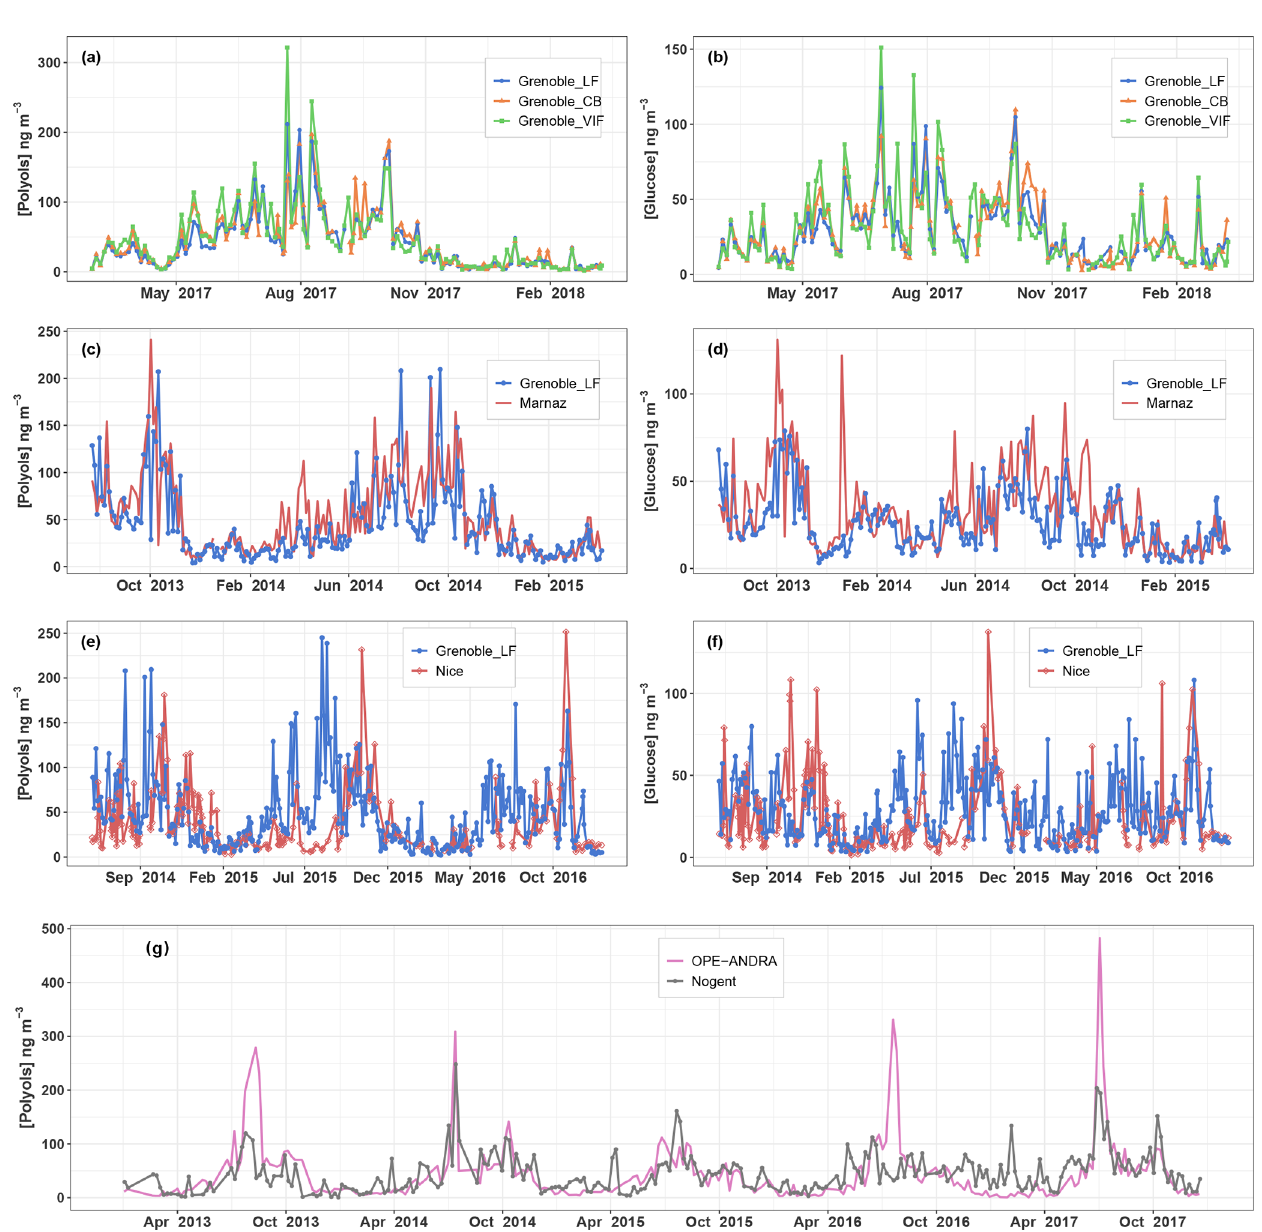
Figure 2. Concentrations (in ngm − 3 ) of (a, c, e) ambient particulate polyols (defined as the sum of arabitol and mannitol) and (b, d, f) glucose over different monitoring sites in France. Since PM 10 were collected every 3d at Nogent-sur-Oise and 6d at OPE-ANDRA, the original datasets are averaged over consecutive 6d intervals ( g